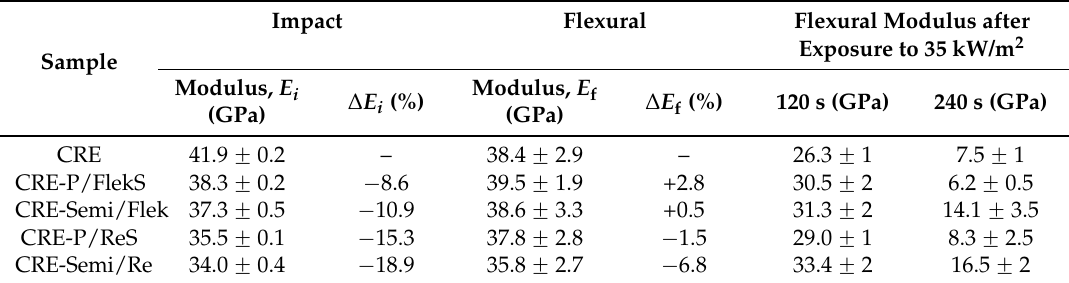
Table 5. The impact and flexural moduli for all CRE composite laminates.